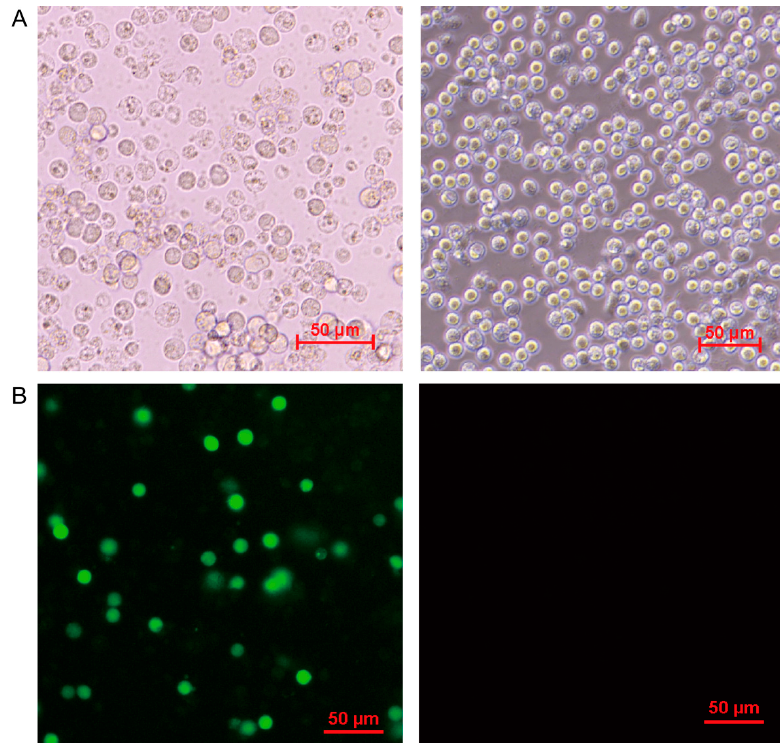
Figure 1. Observation of PAM cells after ASFV infection. ( A ) Typical CPEs caused by ASFV were shown by optical microscope hours 72 h post infection. ( B ) PAM cells were infected by ASFV at MOI of 1. At 24 h post infection, the expression of ASFV encoding protein p30 in PAM cells was detected by indirect immunofluorescence. The left was ASFV-infected PAM cells visual field, the right was mock-infected PAM cells visual field. The red bars in graphs were on behalf of 50 µm.